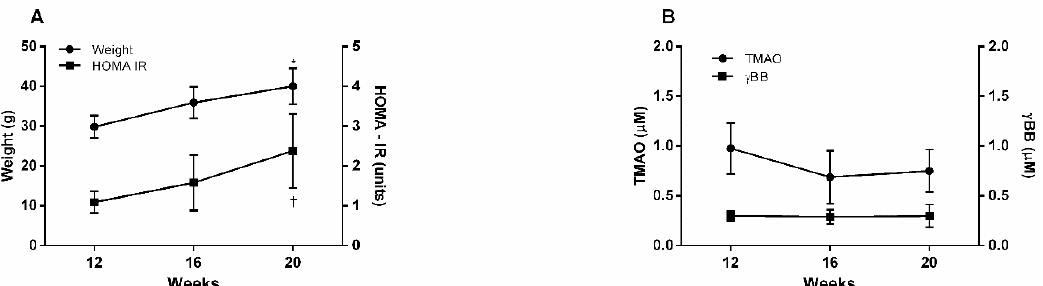
Figure 3. Weight and HOMA-IR ( A ) and serum TMAO and γ BB ( B ) levels in C57BL6/6J mice fed with a Western-type diet. A Friedman test followed by a Dunn’s multiple comparisons test were performed in time-course analyses of mice. * p = 0.0002 (weight at 12 vs. 20 weeks) † p = 0.0005 (HOMA-IR at 12 vs. 20 weeks).